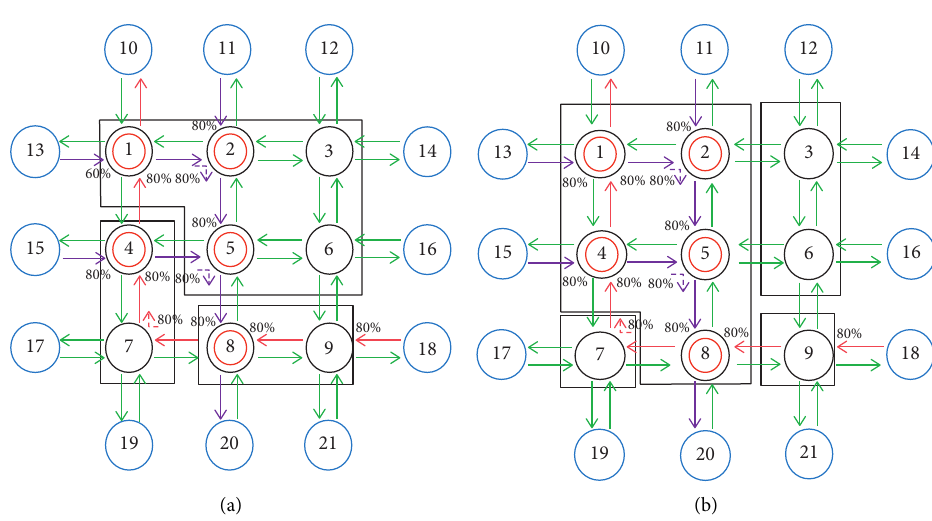
Figure 3: Example of Hybrid clustering based on Newman partition. (a) Newman clustering. (b) Hybrid